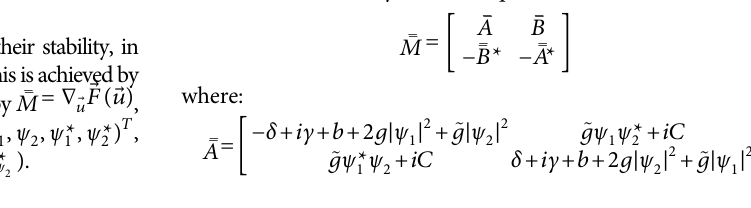
Frontiers in Physics |